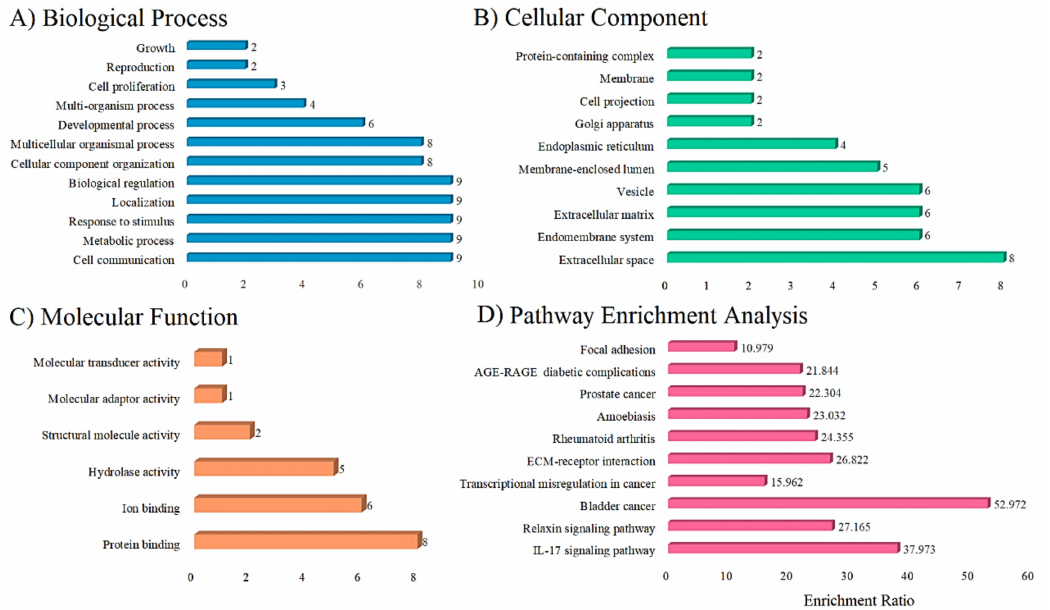
Figure 8. The functional and pathway enrichment analysis visualization mapped with illu- mina_humanht_12_v3 genes as a reference. ( A ) The biological process of HGsT10, ( B ) The cellular component of HGsT10, ( C ) The molecular function of the HGsT10, ( D ) The enriched pathway for HGsT10 with its Enrichment ratio. Furthermore, the FDR and p -values for enriched pathway terms are noted in Table S4 (Supplementary File